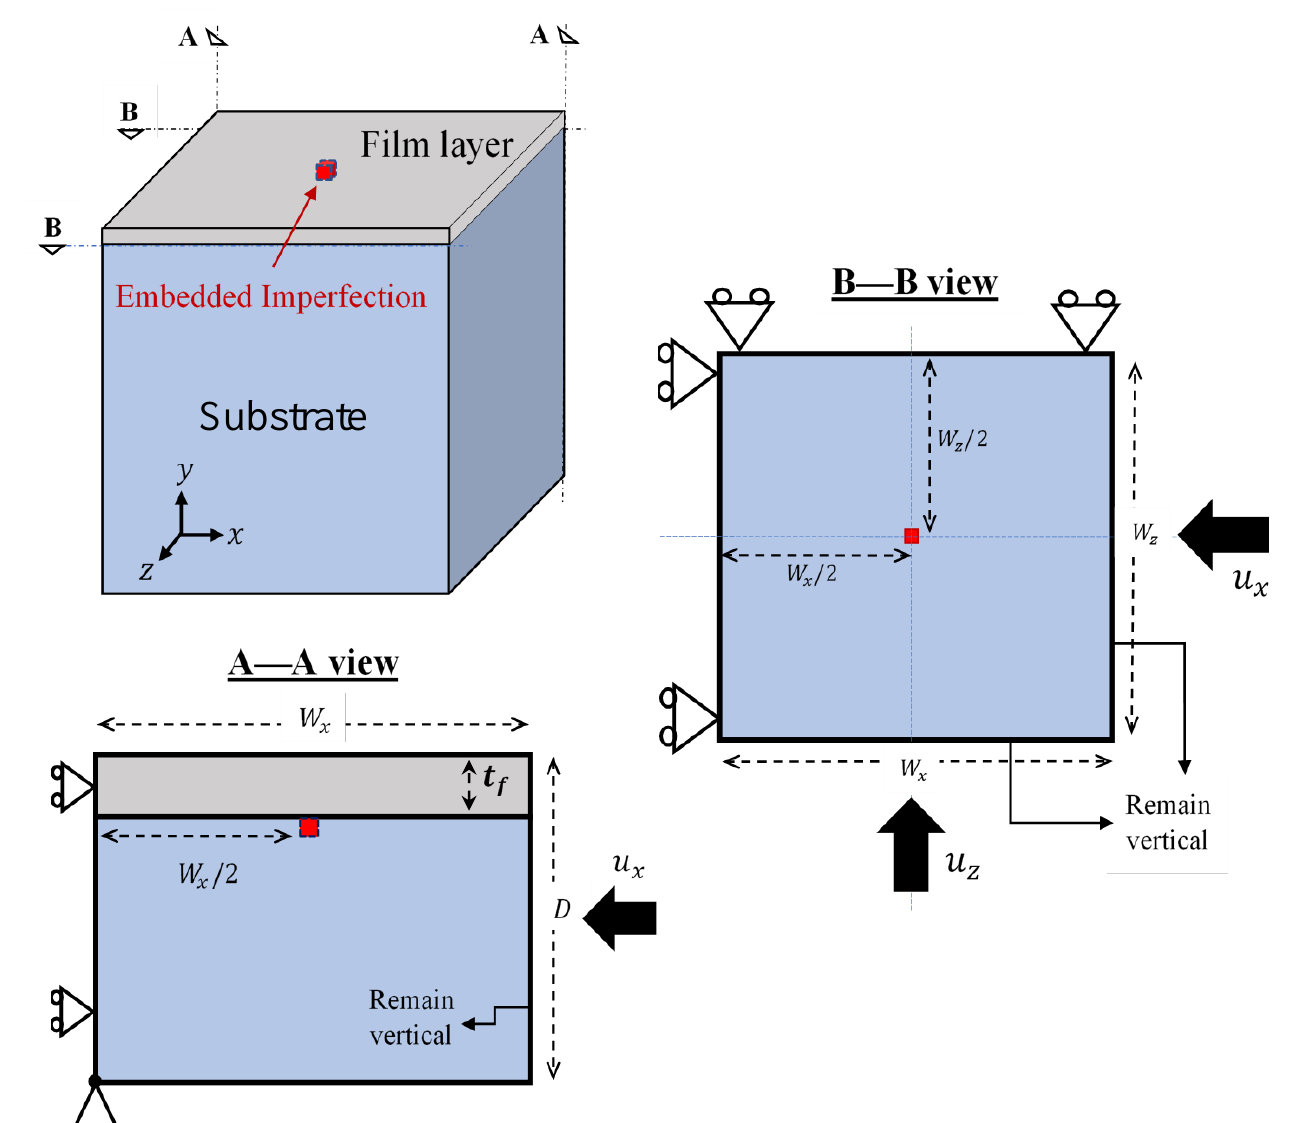
Figure 1. Schematics of the problem geometry, boundary conditions, and directions of the applied displacement [39].